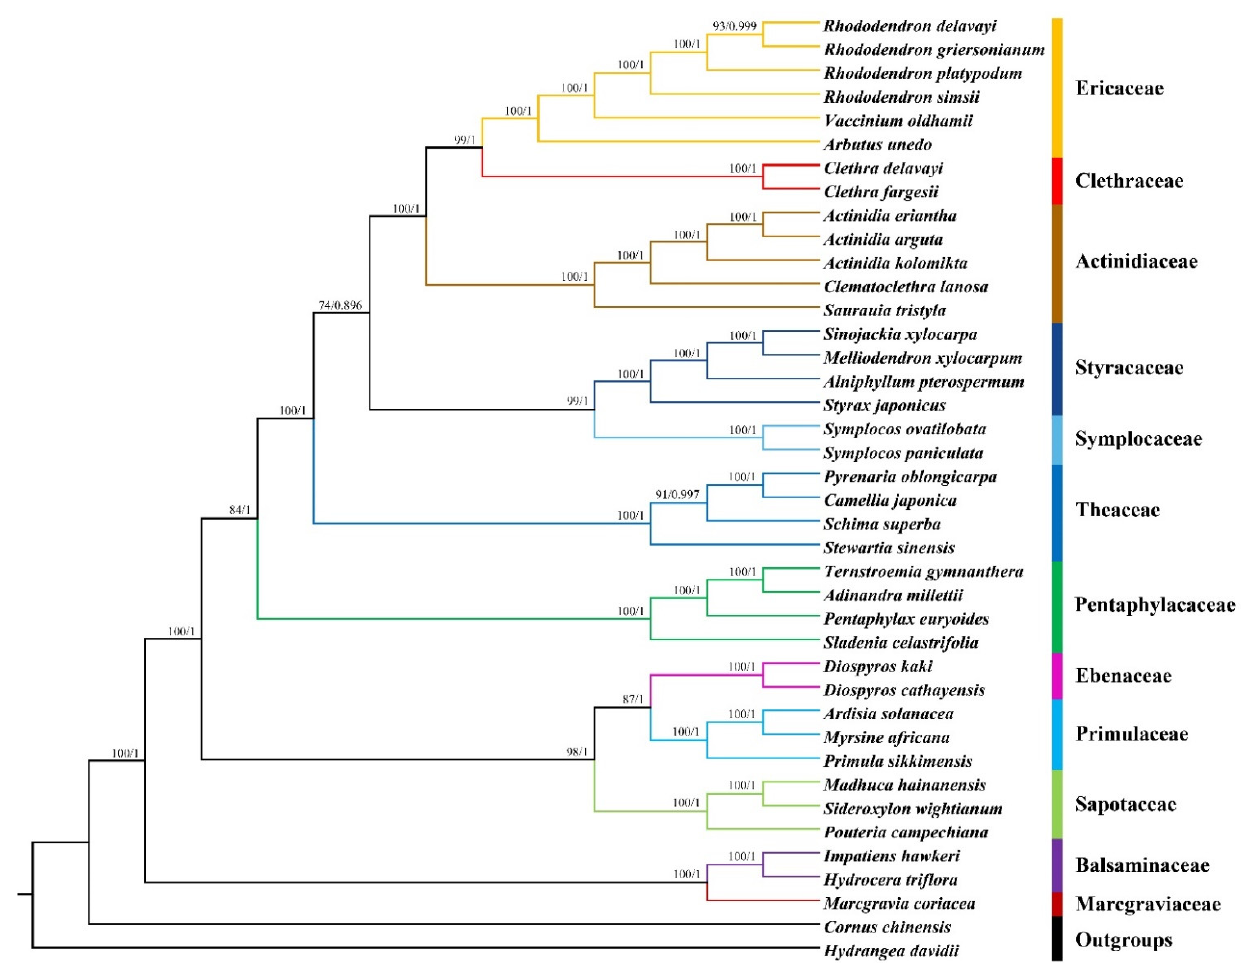
Figure 9. The phylogenetic tree is based on the 75 chloroplast protein-coding sequences of 40 species using maximum likelihood (ML) and Bayesian (BI) methods. The ML tree is consistent with the BI tree in topological structure. The ML bootstrap values/Bayesian posterior probabilities are displayed on the nodes.